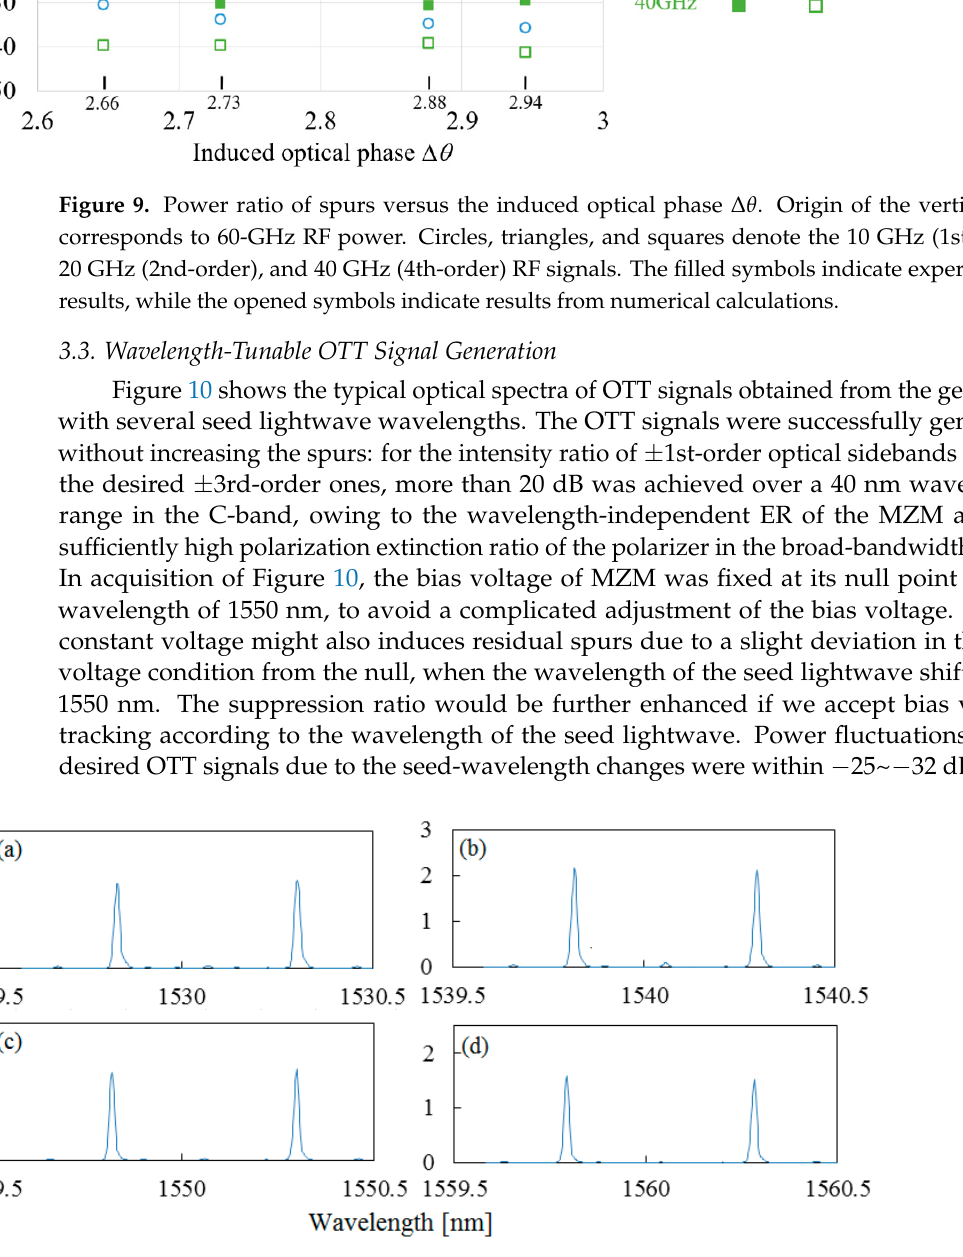
are due to the desired components and the ±5th-order components. Additionally, these